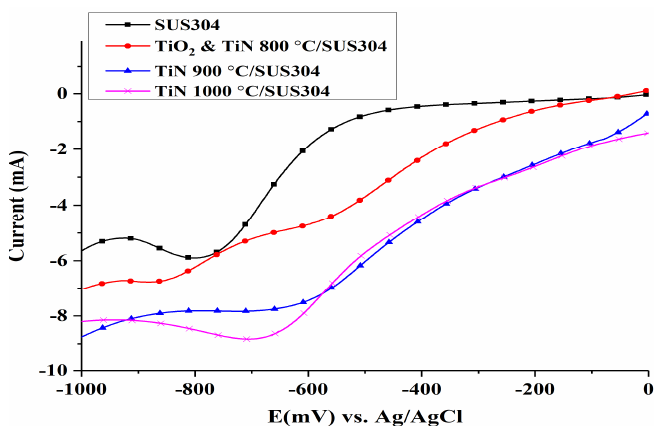
Figure 4. Linear sweep voltammograms of coated and uncoated SUS304 cathodes in the